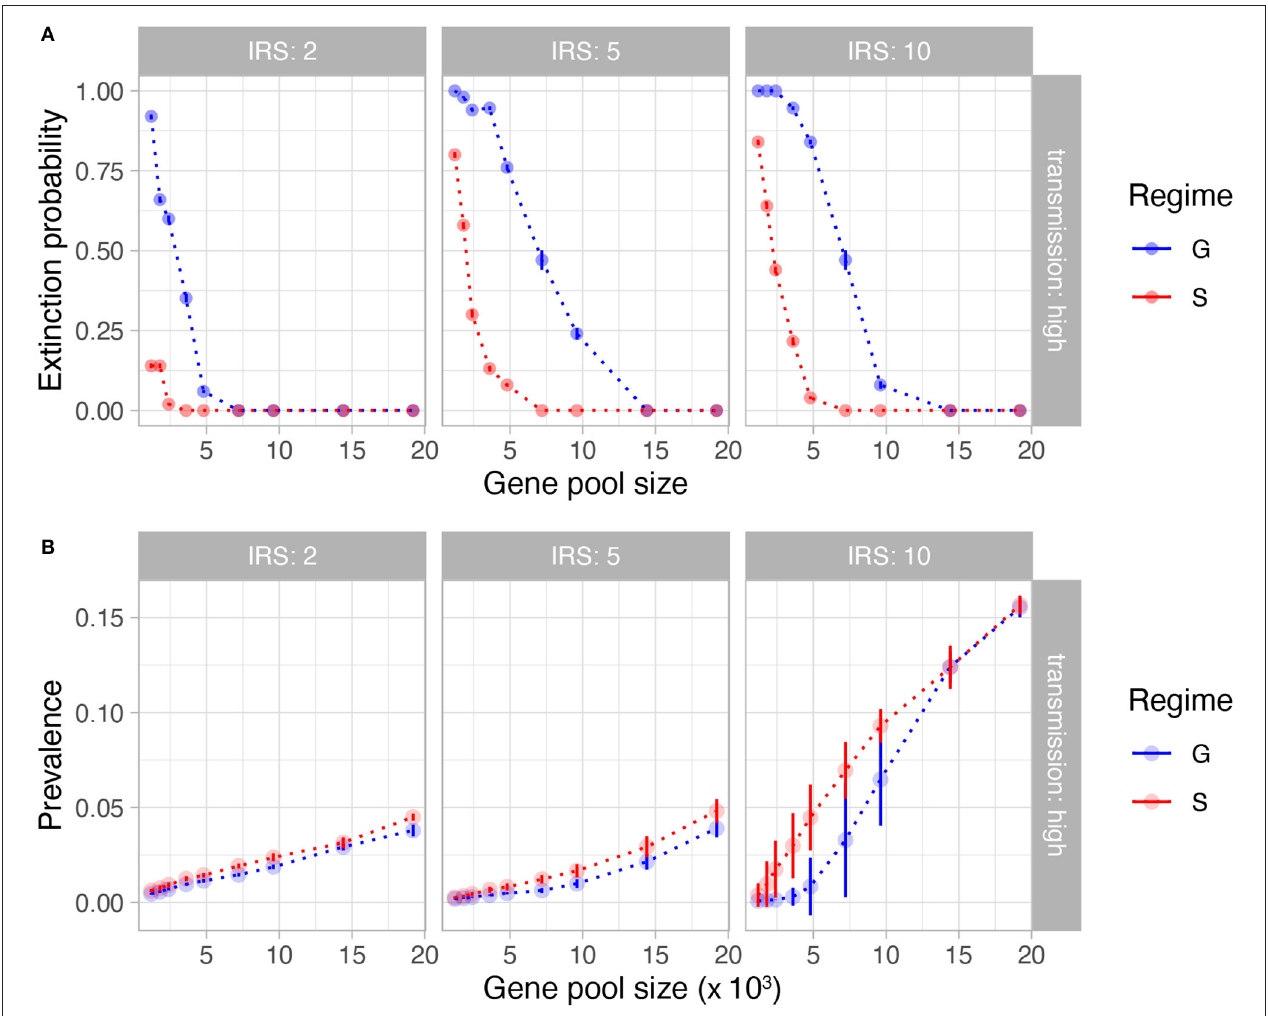
FIGURE 2 | Extinction probability (A) and mean prevalence during IRS (B) as a function of initial gene pool size and lengths of IRS (columns). Shown here are the results from high transmission intensities. See Supplementary Figure 1 for results from low and medium transmission intensities. In (A) , each point is the proportion of simulation runs for the given parameter combination (out of 50 runs) that crashed before the IRS was lifted. In (B) , each point represents the mean value (bars represent standard deviation) of prevalence for those simulation runs that survived the IRS for the given parameter combination. Blue and red colors depict generalized immunity (G, the neutral model) and specific immunity (S, NFDS), respectively. It is clear that despite comparable prevalence, the parasite population is more persistent in the immune selection